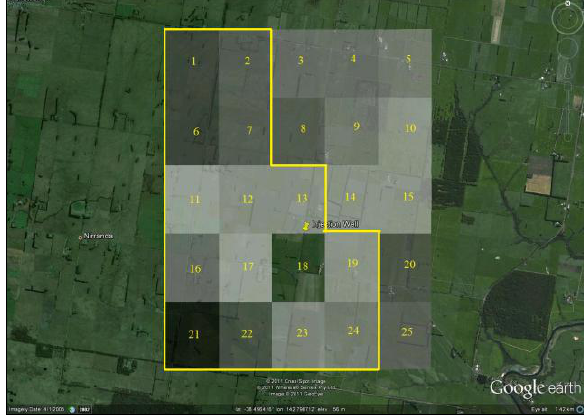
Figure 4. The 25 pixels around the Otway CCS site (selected based on the coordinates of the injection well; latitude: -38.51786, longitude: 142.82143)